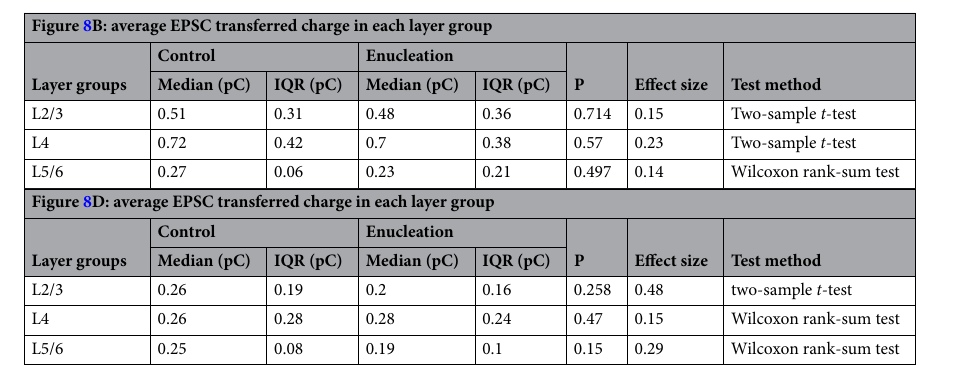
Table 8. Statistics in Fig. 8. IQR interquartile range.